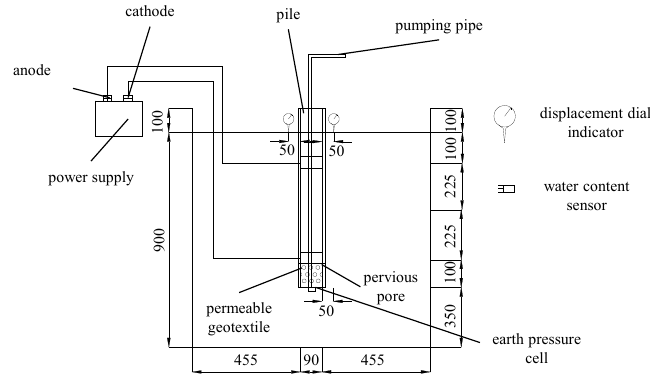
Figure 3. Layout of electro-osmosis from top to bottom.